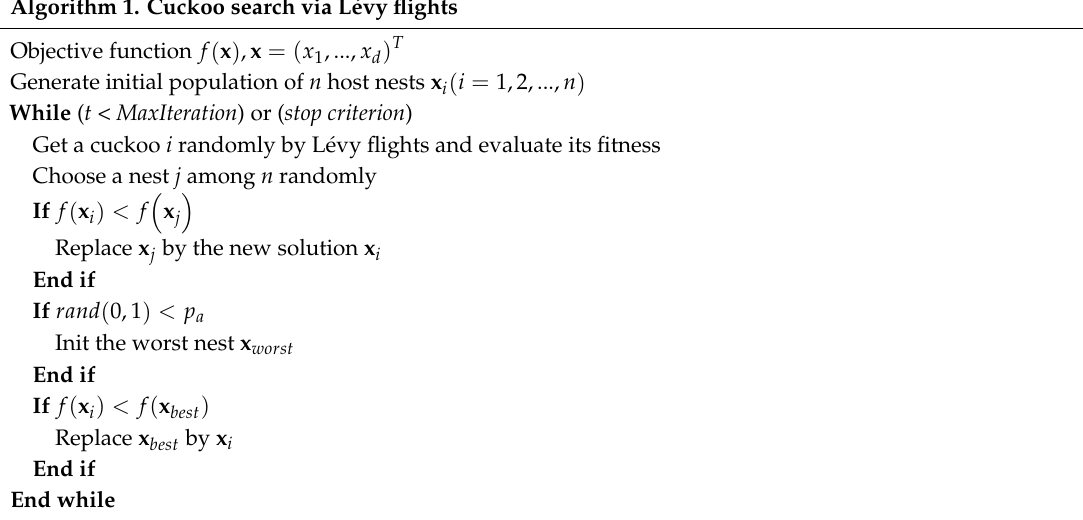
Algorithm 1. Cuckoo search via L é vy